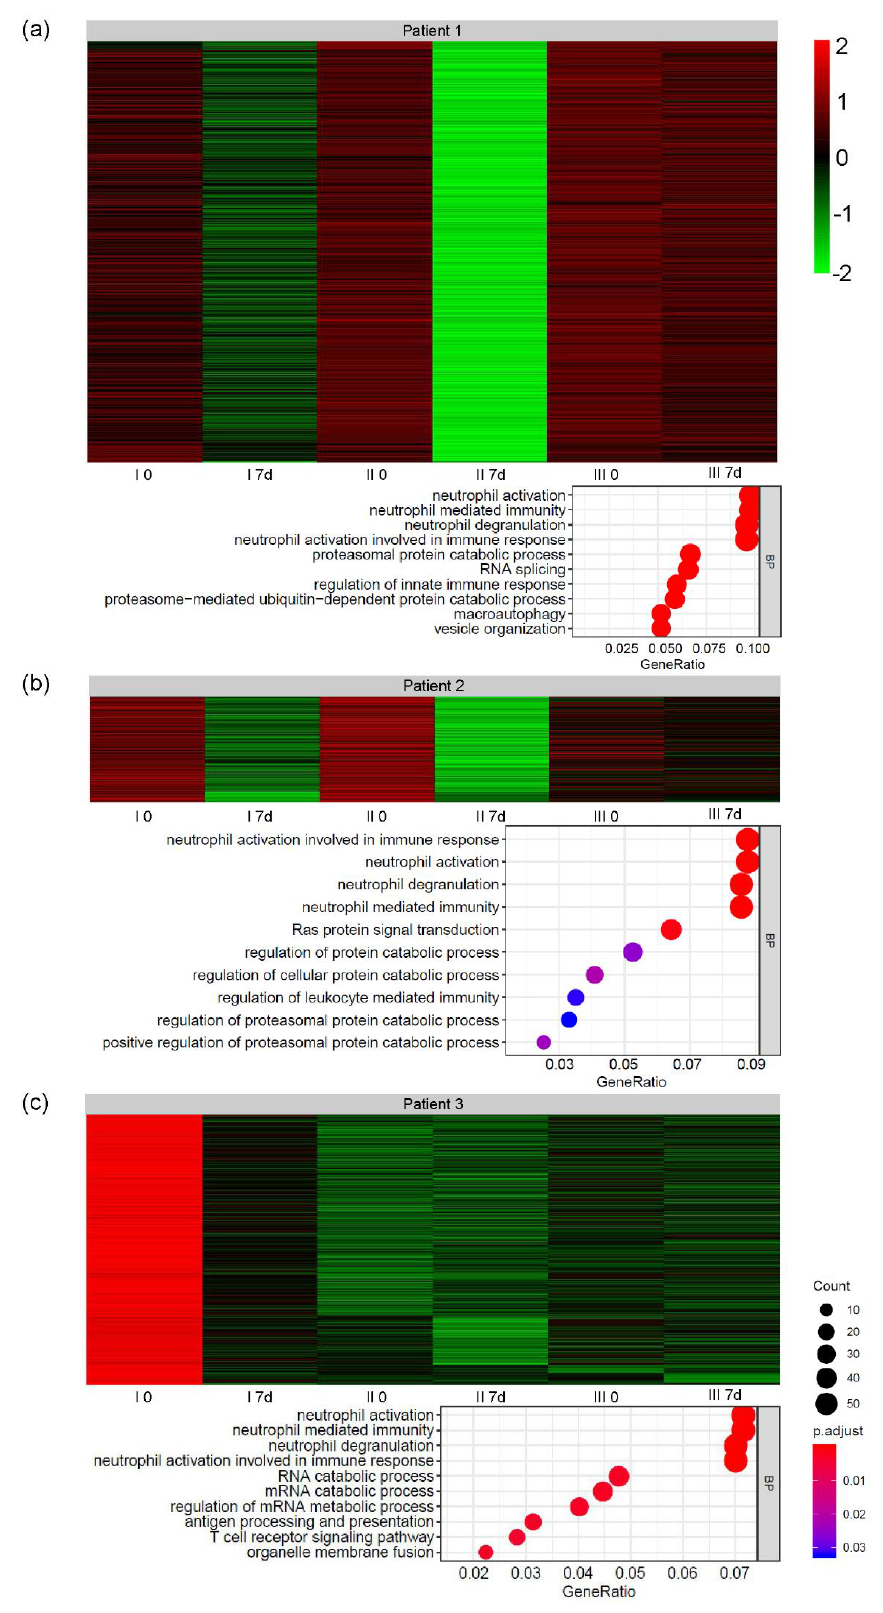
Figure 5. Heatmaps representing the expression of genes assigned to the neutrophil-related gene cluster in all analyzed timepoints for 3 patients: ( a ) Patient 1, ( b ) Patient 2, and ( c ) Patient 3. Bubble plots depict the assignment of genes to biological processes based on gene ontology